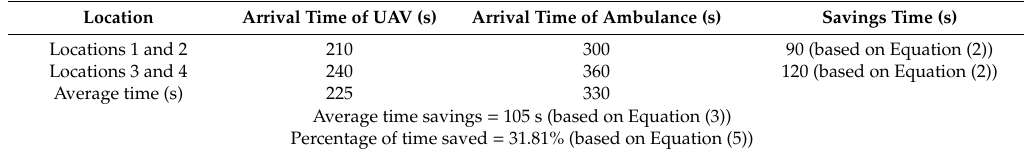
Table 4. Time profile of UAV and